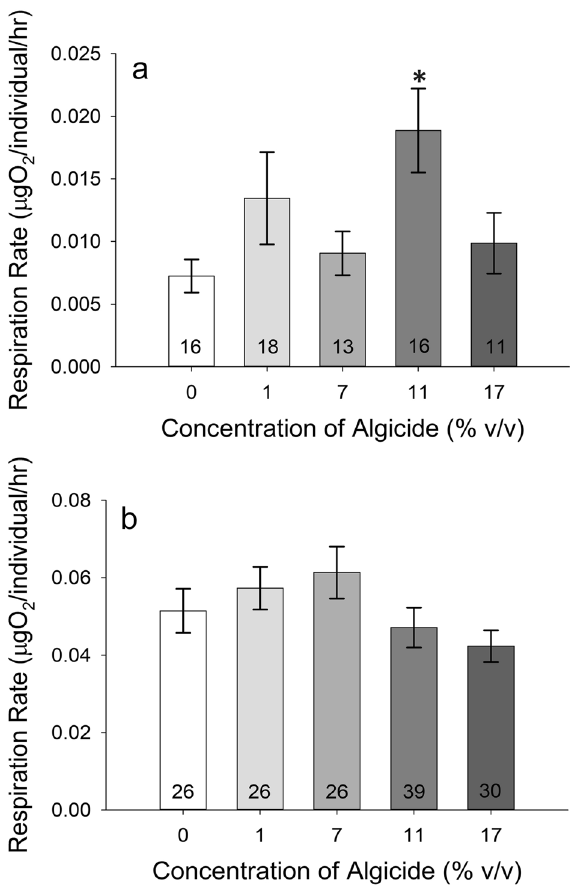
Figure 3. Respiration rates of Acartia tonsa ; numbers on the bars represent sample size. ( a ) Respiration rate of nauplii A. tonsa as a function of algicide concentration. There was a statistically significant difference between the rates of the 11% animals and the 0% control animals (one-way ANOVA on Ranks, p = 0.039; Dunn’s Method post hoc, p = 0.012). (b) Respiration rate of adult female A. tonsa as a function of algicide concentration. (* p <